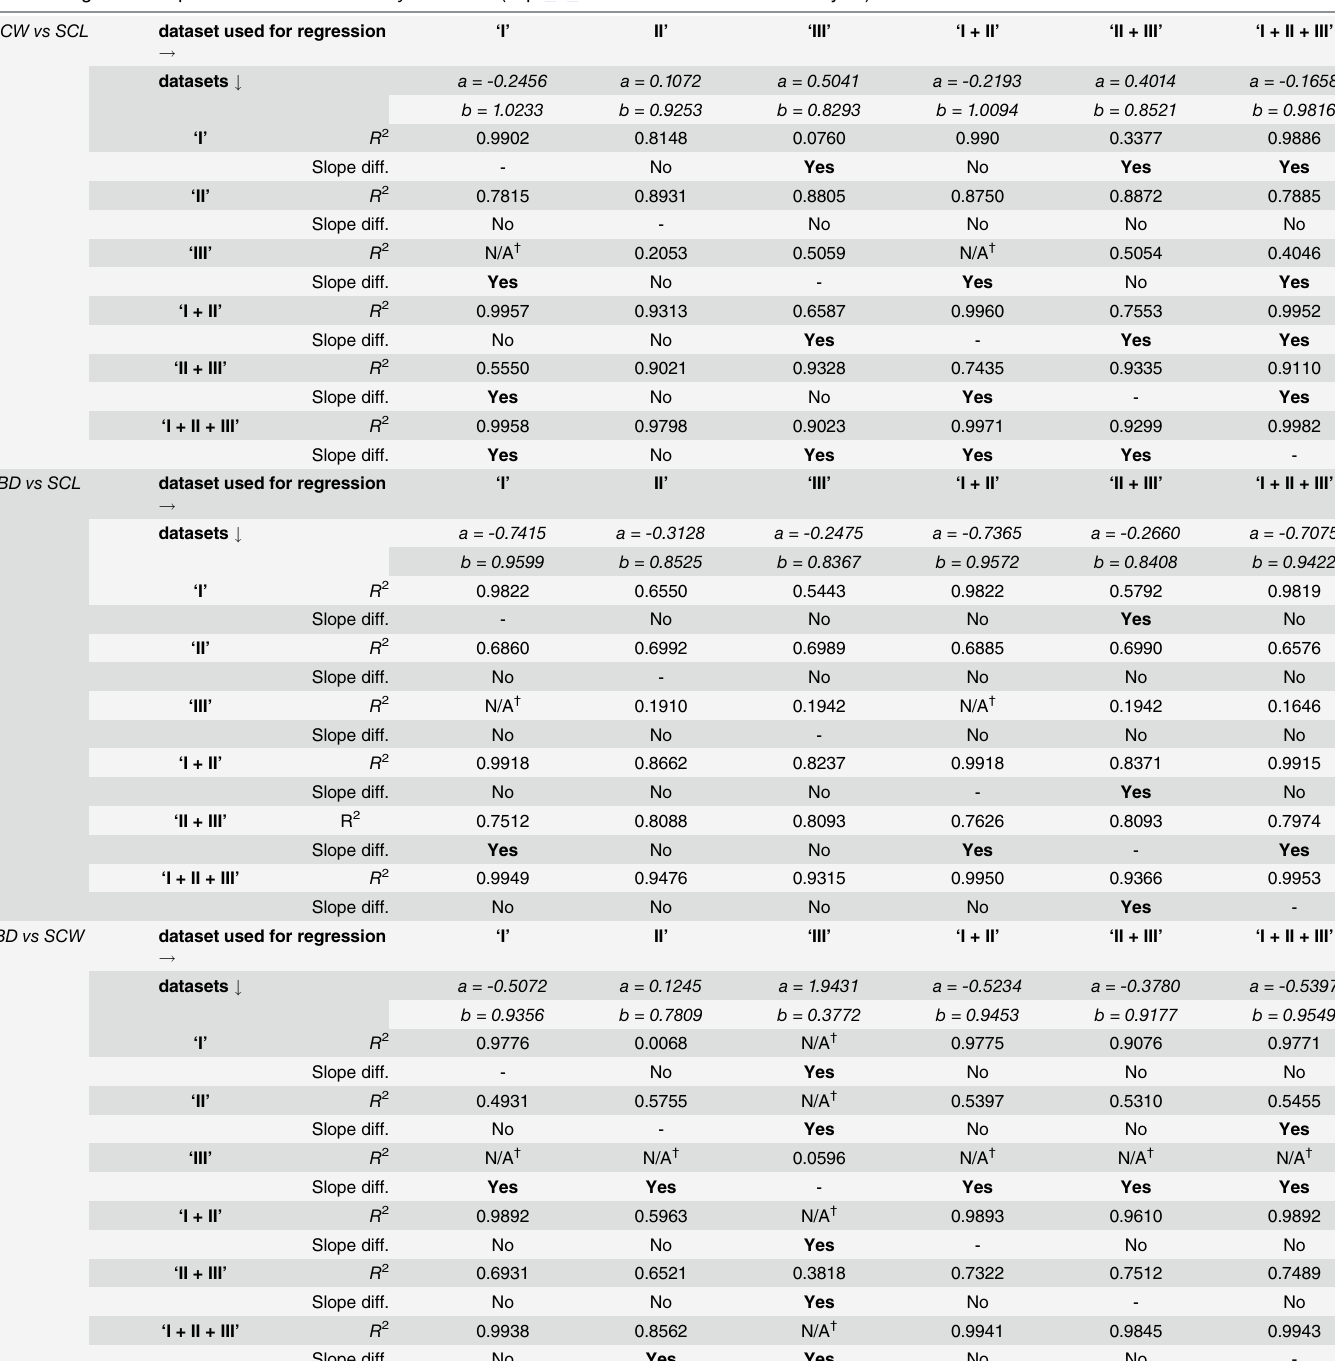
Table 5. Analysis of linear scaling models for life stage datasets. For each dataset (listed under ‘ datasets ’ ) we analyzed the performance of six predictive regression equations, differing only in the values of model parameters. Parameter values are given under the name of the dataset used for regression. R 2 value describes the goodness of fit of the regression equation listed in the column to the dataset listed in the row. We marked for readability R 2 values when the regression equation was used for the dataset it was fitted on. ‘ Slope diff ’ indicates whether or not the slopes of two regression equations are significantly different (Tukey-Kramer test, p < 0.05), where one regression equation is specific for the dataset listed in the row, and the other for the dataset listed in the col- umn. All regression equations are in the form of y = a + b (cid:2) x (Eqs 1 – 3 in Models and statistical analysis). See subsection Data for definitions. SCW vs